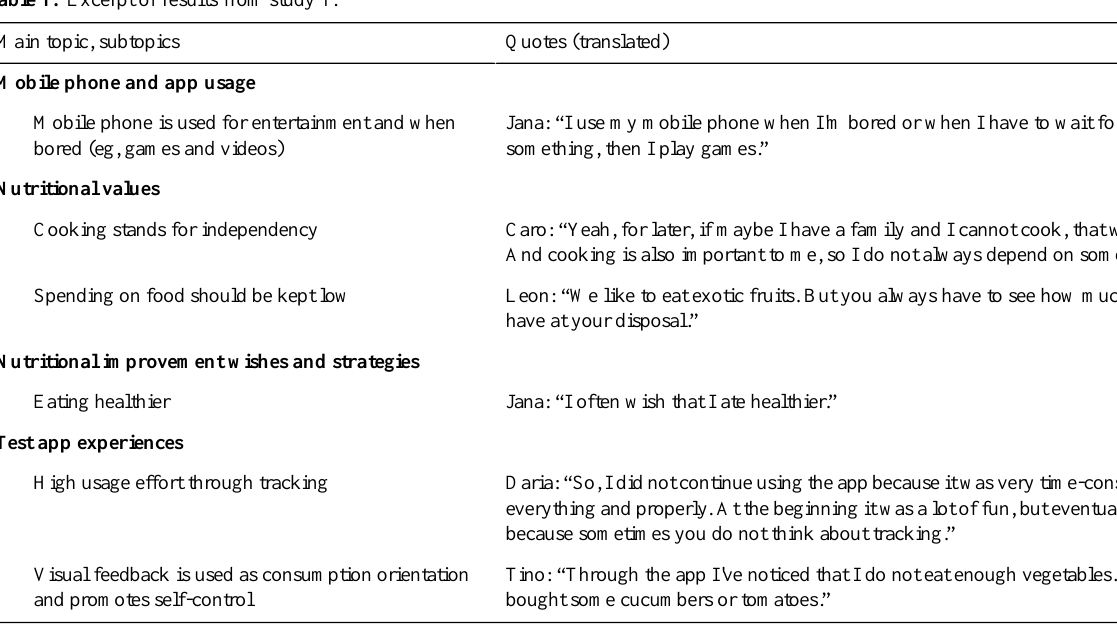
Table 1. Excerpt of results from study 1.